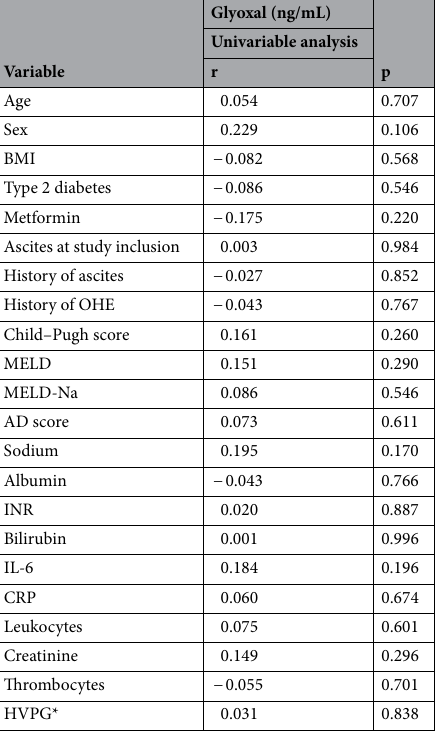
Table 3. Univariable analysis for predictors of higher glyoxal levels in patients with liver cirrhosis. AD acute decompensation, BMI body mass index, CRP C-reactive protein, OHE overt hepatic encephalopathy, IL-6 interleukin-6, INR international normalized ratio, HVPG hepatic venous pressure gradient, MELD model for end-stage liver disease, MELD-Na model for end-stage liver disease-sodium. A univariable analysis of the data is shown. Boldface indicates significance. A p value < 0.05 was considered significant. *Measured in 46